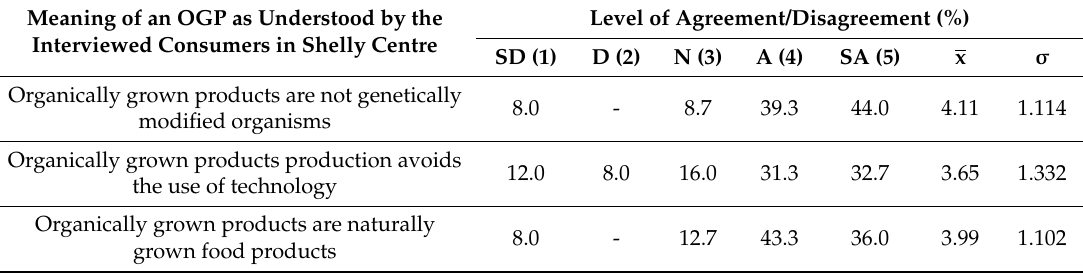
Table 5. Meaning of organically grown products as understood by interviewed consumers in Shelly Centre (n = 150).